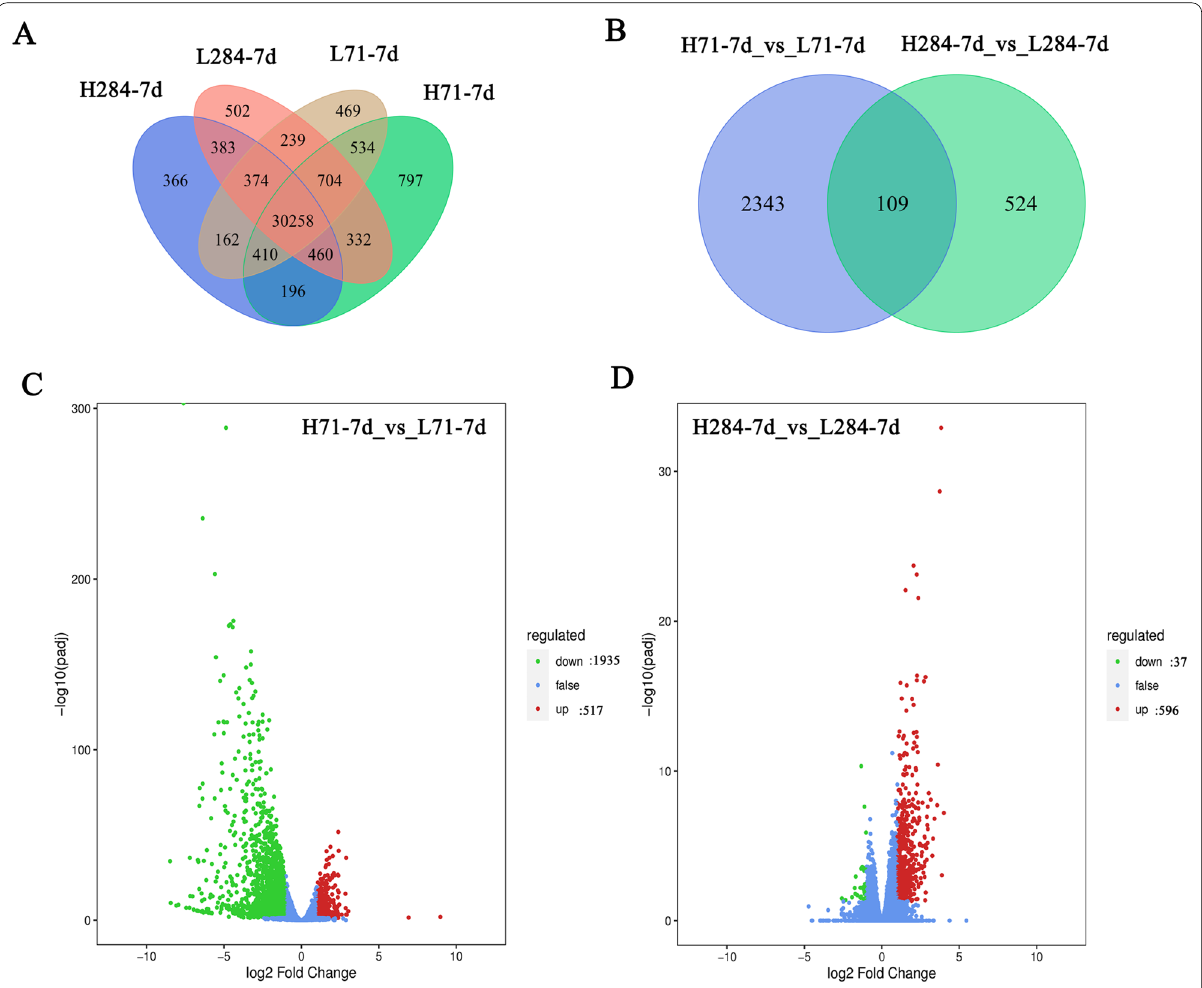
Fig. 5 The differential expressed genes (DEGs) in roots. A Venn diagram of DEGs among different samples. B Venn diagram of DEGs between two comparative groups. C and D The volcano plots of two comparative groups. X-axis and Y-axis present the value of log 2(ratio) and two comparative groups, respectively. Red (Up regulated) and green (down regulated) dots indicated that the genes have significant expression difference, while the blue dots represent genes with no significant differences. H71-7d: The samples of Longjing 31 treated under high-nitrogen treatment for 7 days. L71-7d: The samples of Longjing 31 treated under low-nitrogen treatment for 7 days. H284-7d: The samples of Songjing 10 treated under high-nitrogen treatment for 7 days. L284-7d: The samples of Songjing 10 treated under low-nitrogen treatment for 7